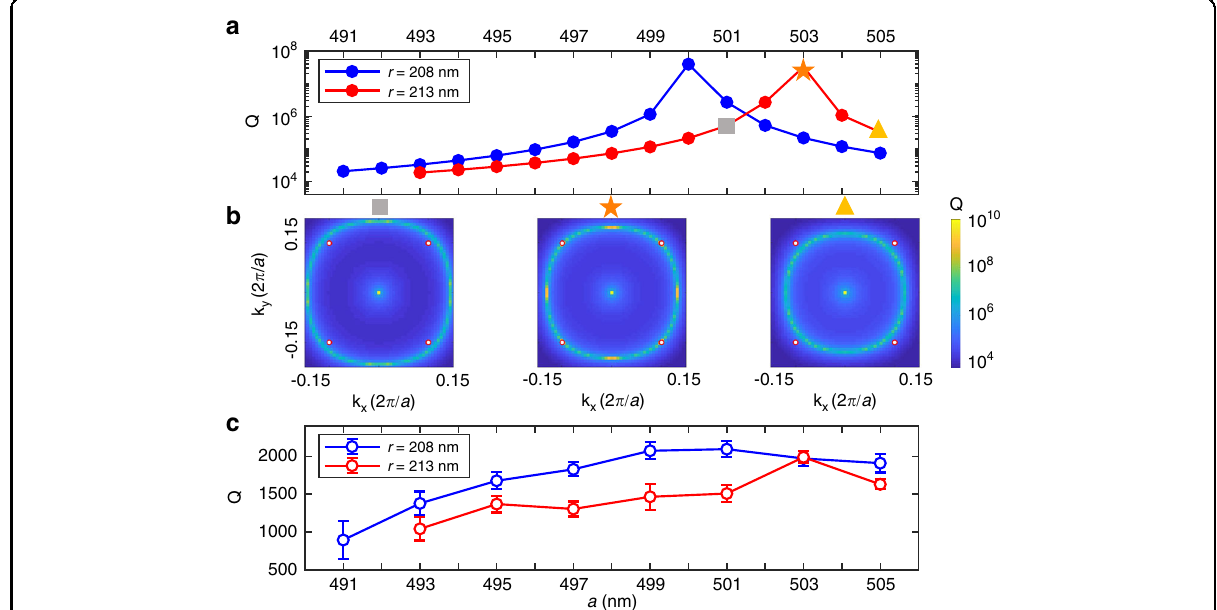
Fig. 4 Enhancement of the Q factor by topological charge engineering. a Simulated Q factor of the lasing M 11 mode at N a = 5 as the function of the period a varying from 491 to 505 nm, with different hole radius r of 208 nm (blue dot solid line) and 213 nm (red dot solid line). b The high-Q ring arising from the constellation of multiple BICs appears on bulk band TE A in momentum space. When the period a increases, the ring shrinks toward the center Γ point and eventually reaches the states of M 11 for N a = 5 (red circles) at a = 503 nm. c The measured Q factor of M 11 for varied a , which shows similar trend with simulated results. The error bars correspond to standard errors deduced by fi